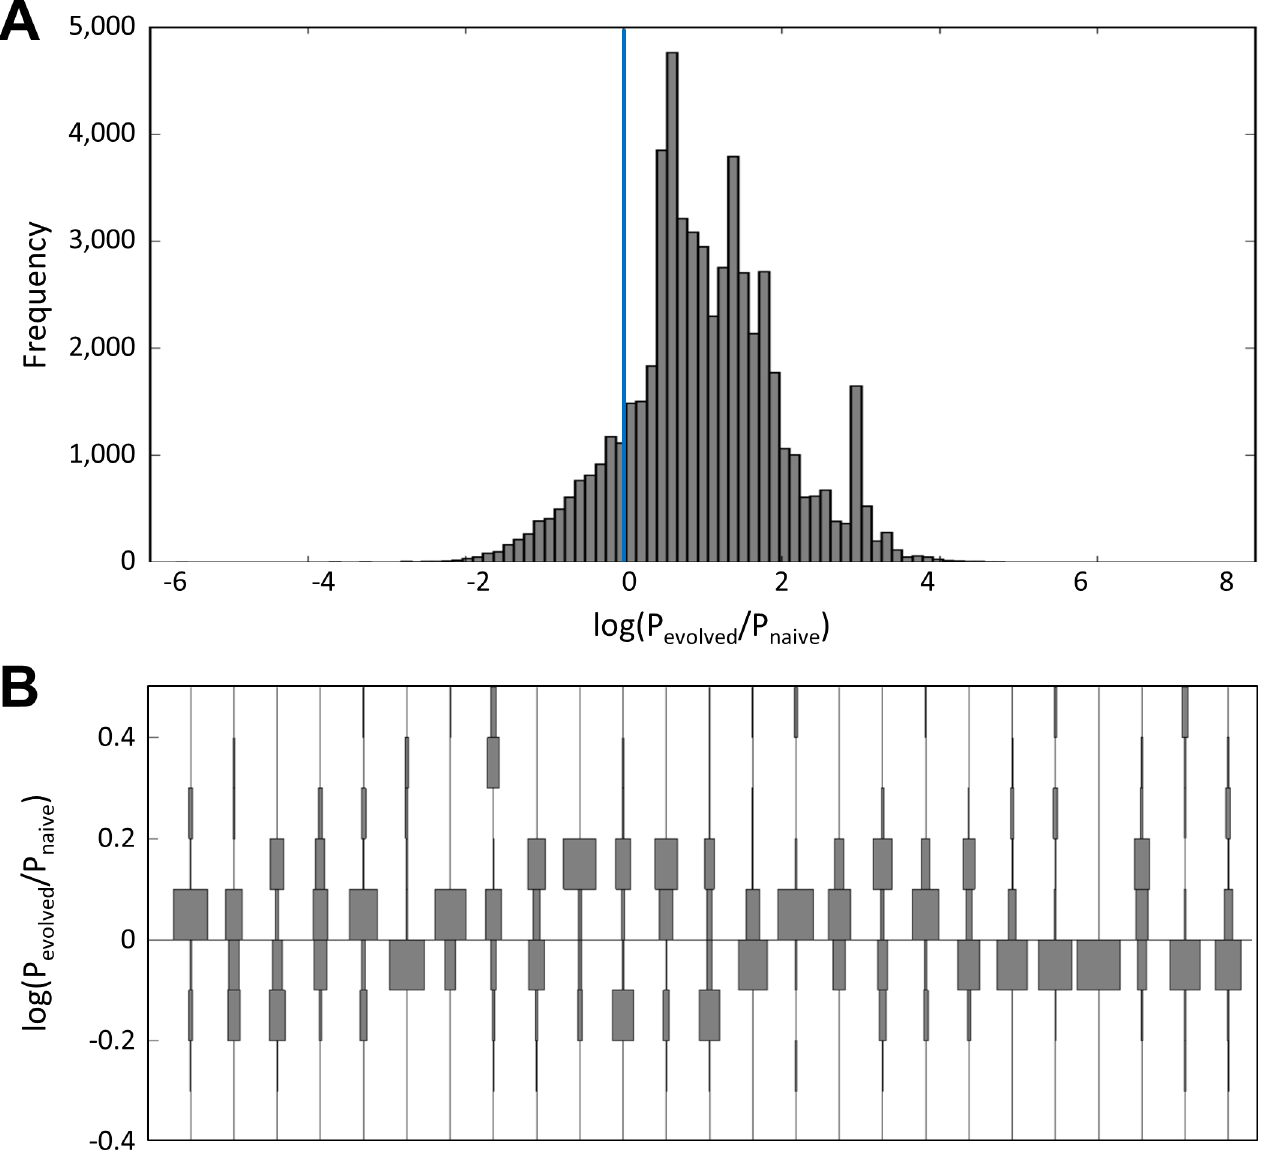
Fig 3. Distribution of evolutionary probabilities from the original and evolved repertoires. To estimate the likelihood of an evolved clone to have been identified from either the first generation repertoire or from that which is observed within the evolved population of binders, an exhaustive leave-one-out cross-validation (LOOCV) was conducted. The training set consisted of n-1 sequence clusters derived from the first generation mid-and high-affinity evolved binder data. Using the training set sequence clusters, a sitewise frequency matrix was calculated. The cross-validation test set consisted of a single sequence cluster that had been excluded from the training set analysis. Each sequence within the test set was assigned a probability for being observed within the original library (P naive ) and the training set (P evolved ). Log-odds score, log(P evolved /P na ï ve ), histograms are shown for test set sequences (A) and further evaluated on a sitewise basis